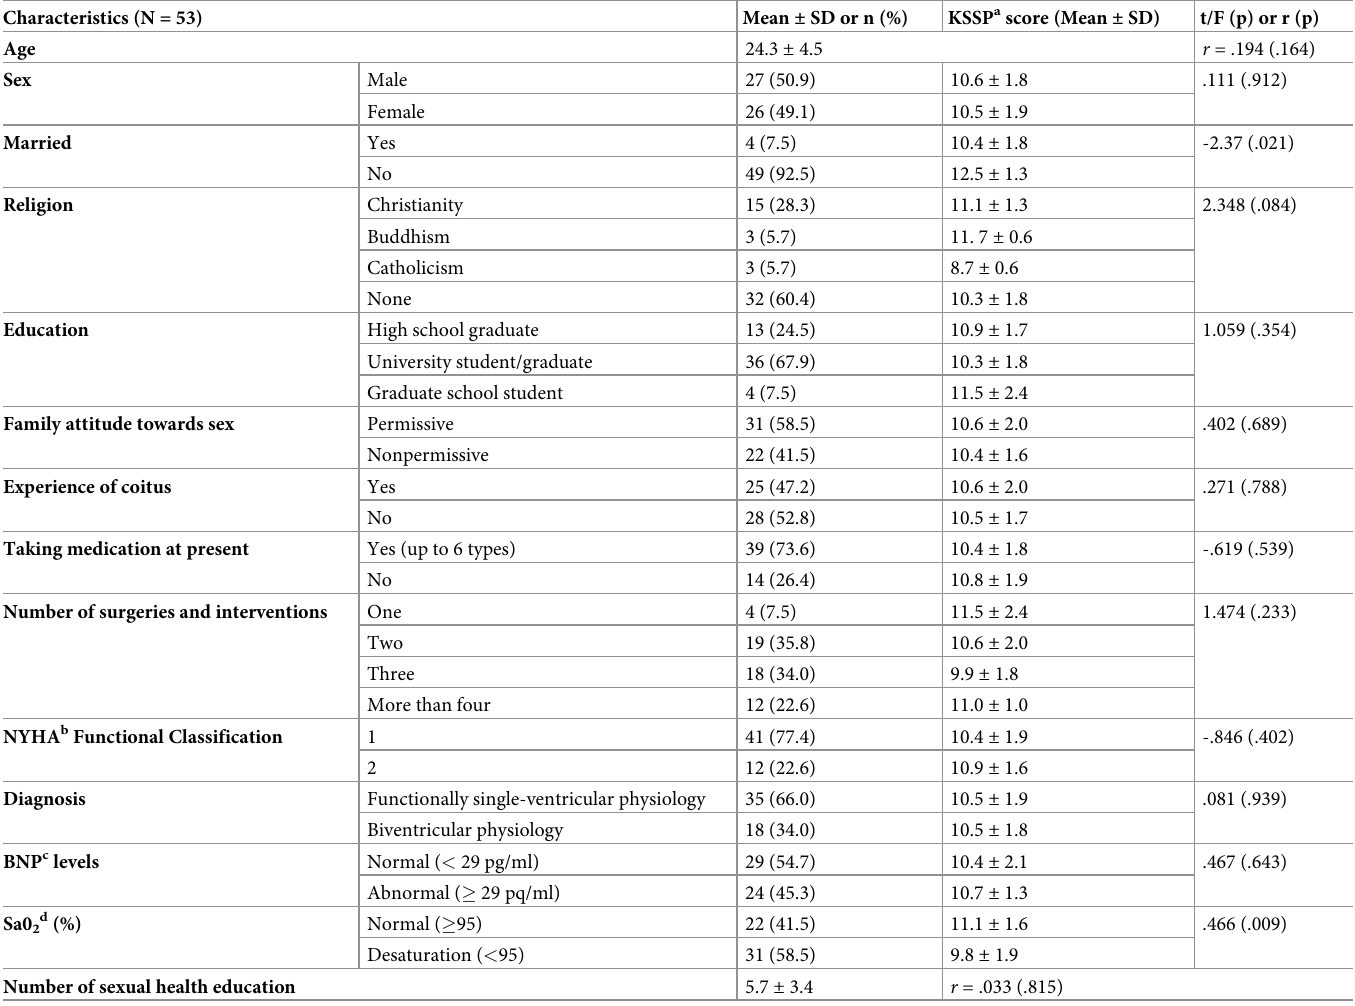
Table 1. Association of knowledge related to safe sex practice scores with participant